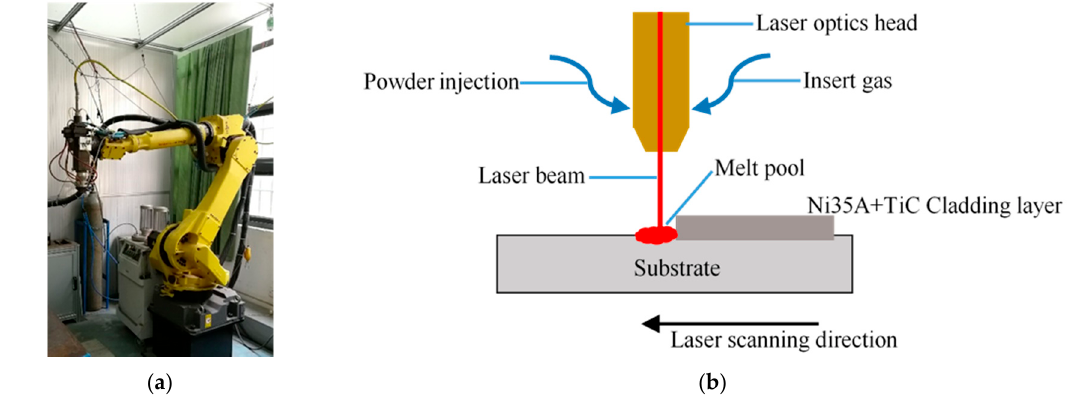
Figure 2. Laser cladding system. ( a ) Experimental setup; ( b ) Schematic diagram.